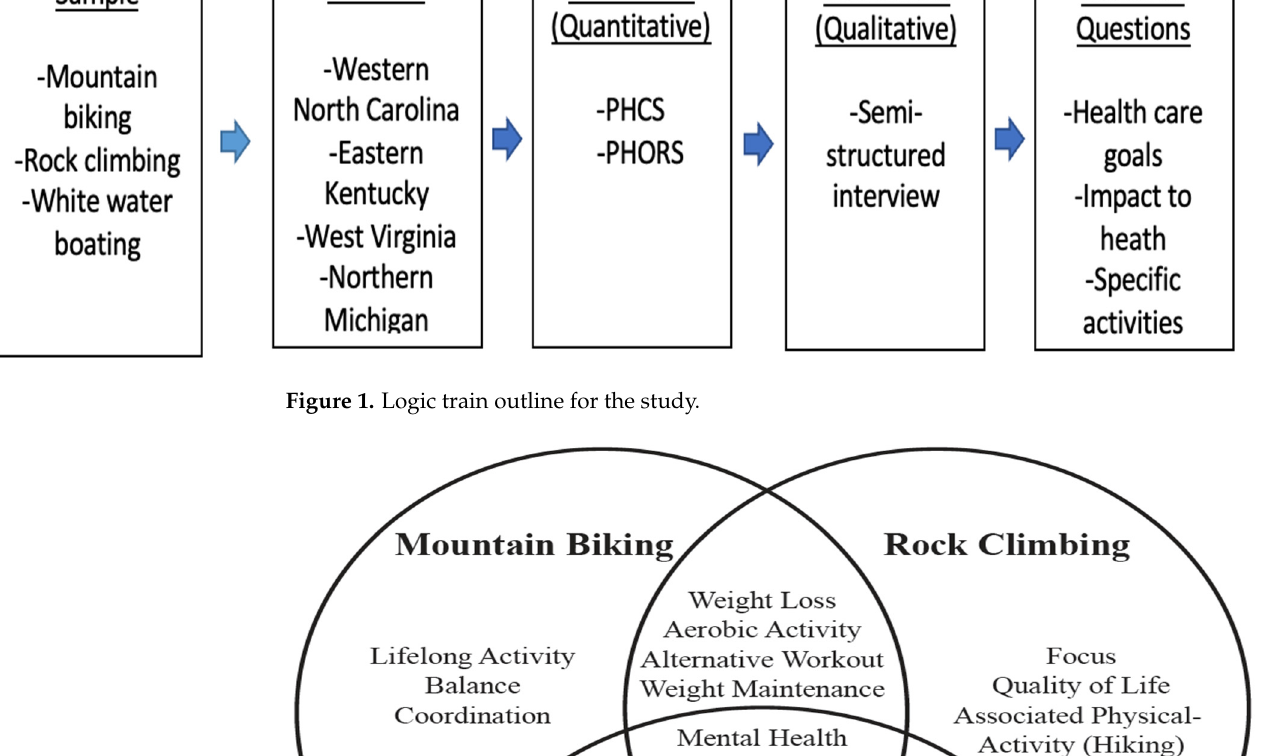
Figure 1. Logic train outline for the study.